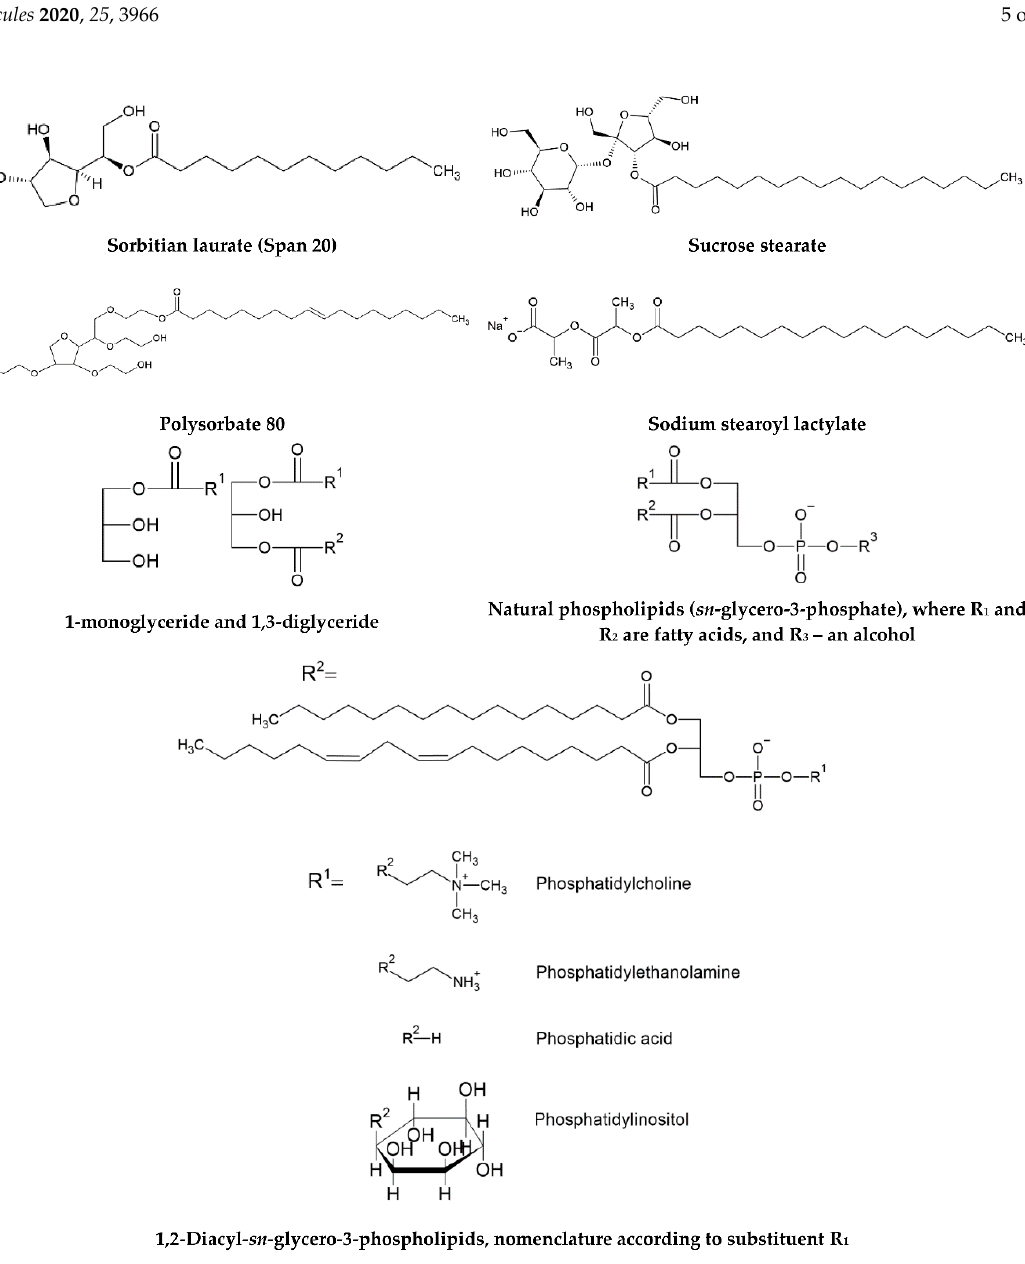
Figure 2. Chemical structure of some food emulsifiers .